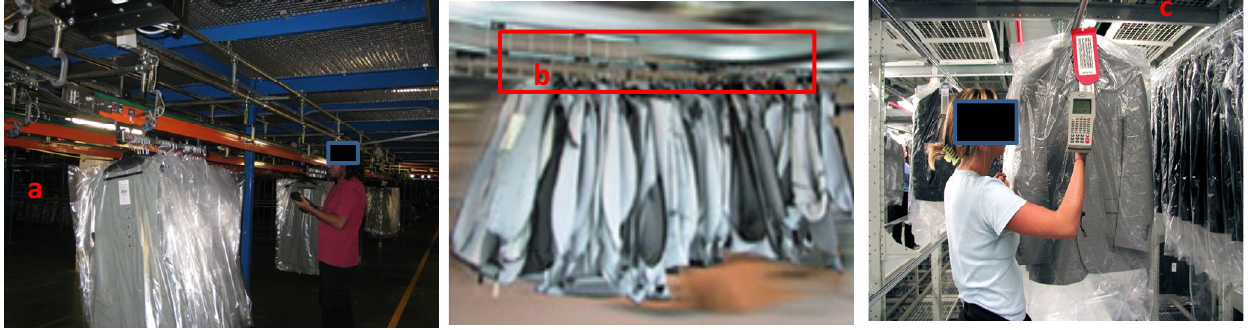
of clothing units. ( b ) Continuous chain system. ( c ) Storing area of a batch in continuous chain